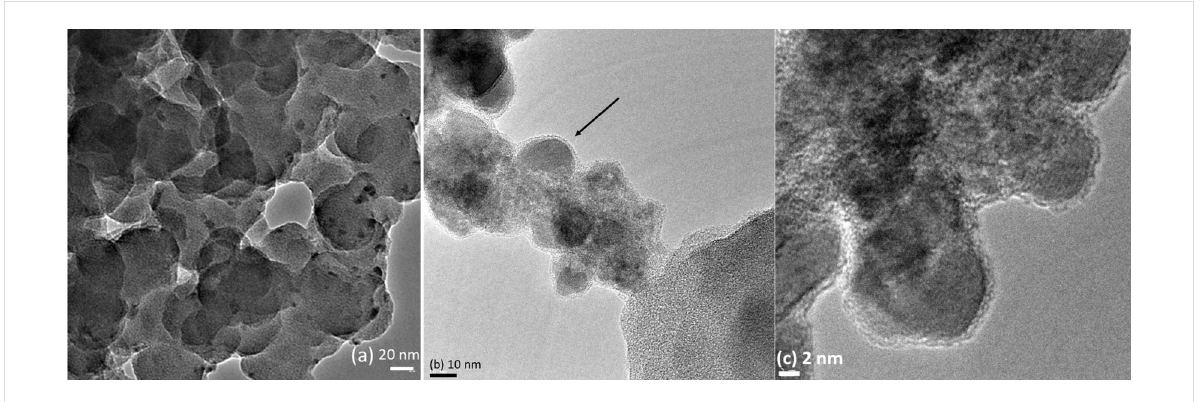
Figure 5: Transmission electron micrographs of magneto-electric composites (a) cluster of composites (b and c) particles of hexaferrite enclosed by polyaniline (CL6P).